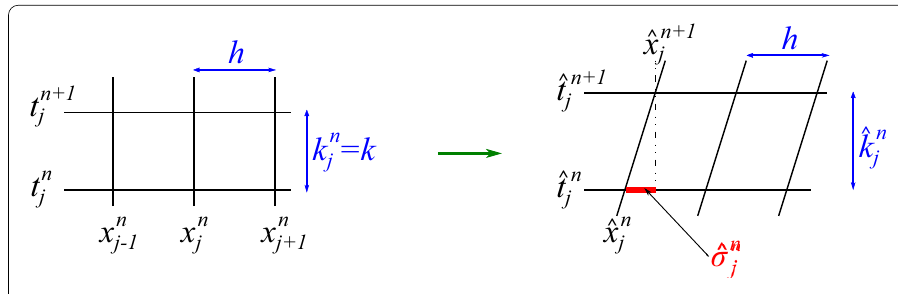
Fig. 22 Transformation of the grid under the moving frame relative to g 1 ◦ g